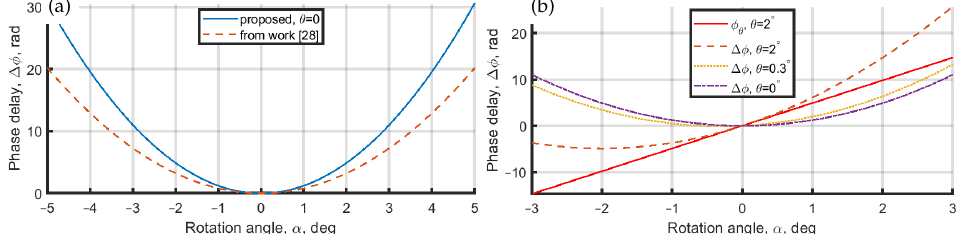
Figure 2. Phase delay in rotated PPP. ( a ) Phase delay with no inclination among reference and object wavefronts. The solid blue line is for the proposed phase delay estimation, dashed orange curve is for phase delay from the paper [28]. ( b ) Phase delay dependence on θ inclination angle between reference and object wavefronts. The solid red line is phase shift, ϕ θ because of inclination on θ = 2 ◦ , a dotted orange curve is phase delay with θ = 0, a dash-dot purple curve is phase delay with θ = 0.3 ◦ , and dashed orange curve is phase delay with θ = 2 ◦